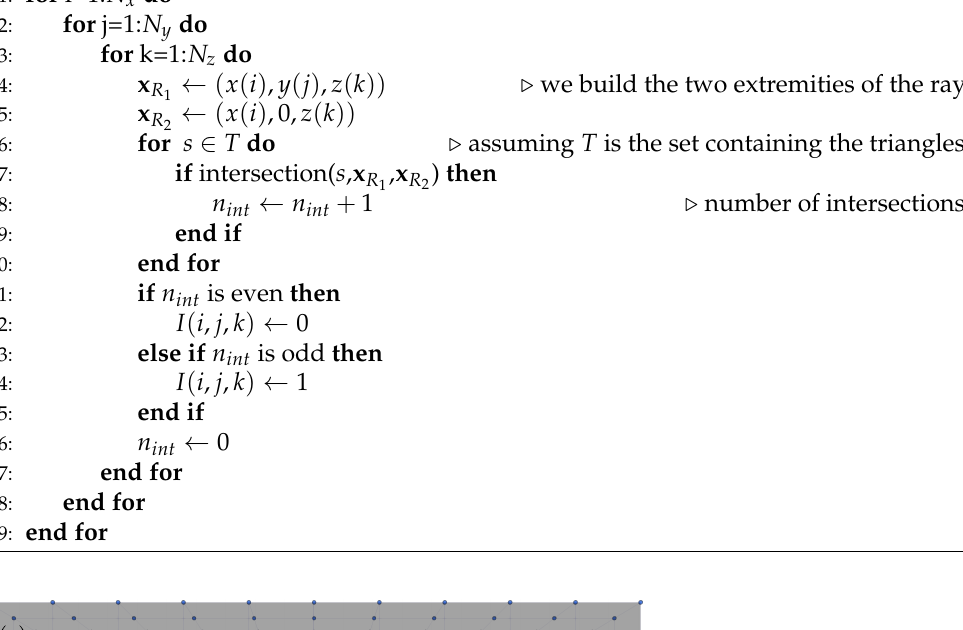
Algorithm 1 Computation of the indicator function ( I ) on a grid of size N x × N y × N z .